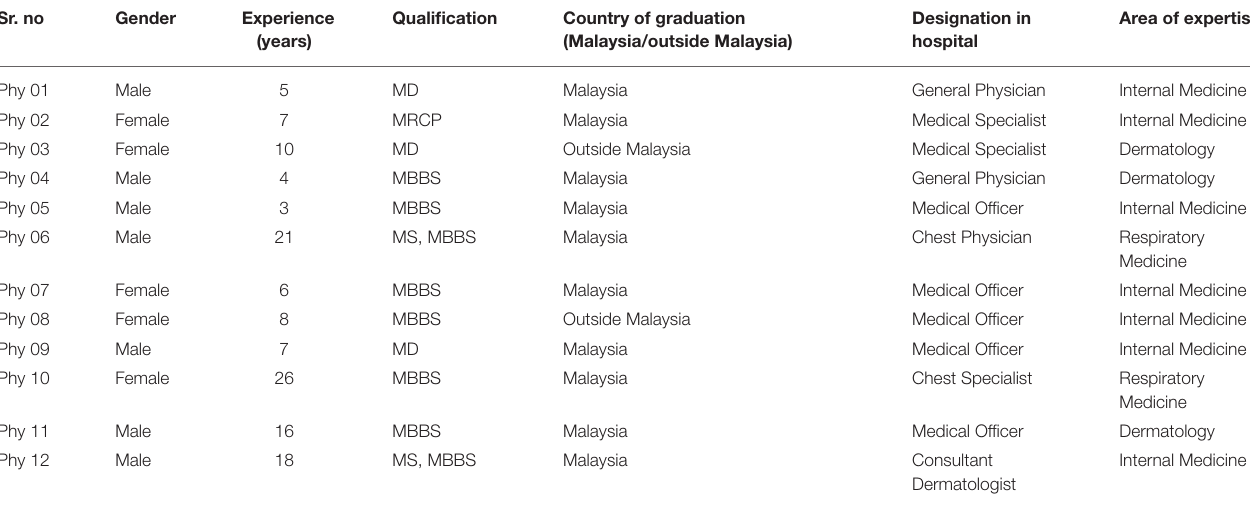
TABLE 1 | Demographics of physicians. Sr. no